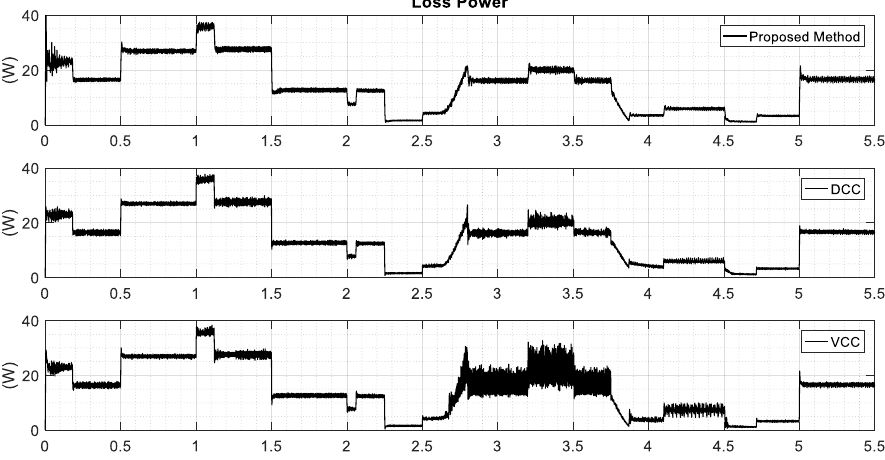
Figure 9. Comparative power loss results of PMSM.